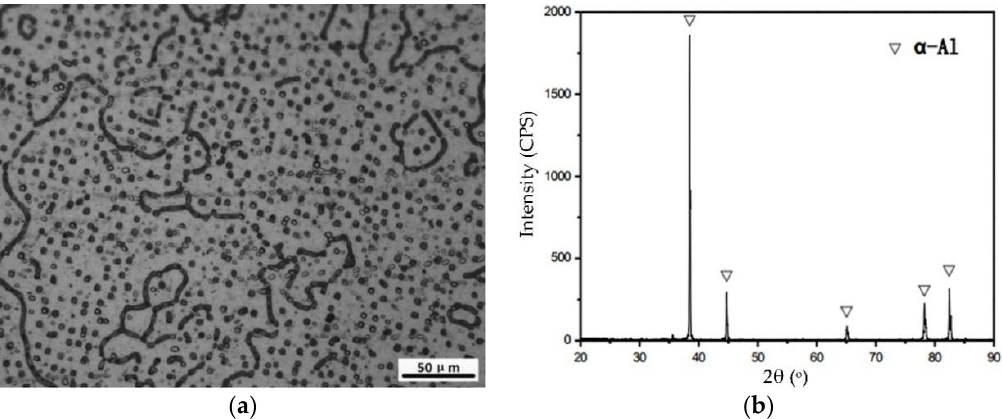
Figure 1. Pure aluminum substrate: ( a ) Microstructure; ( b ) X-ray diffractometer (XRD) pattern.